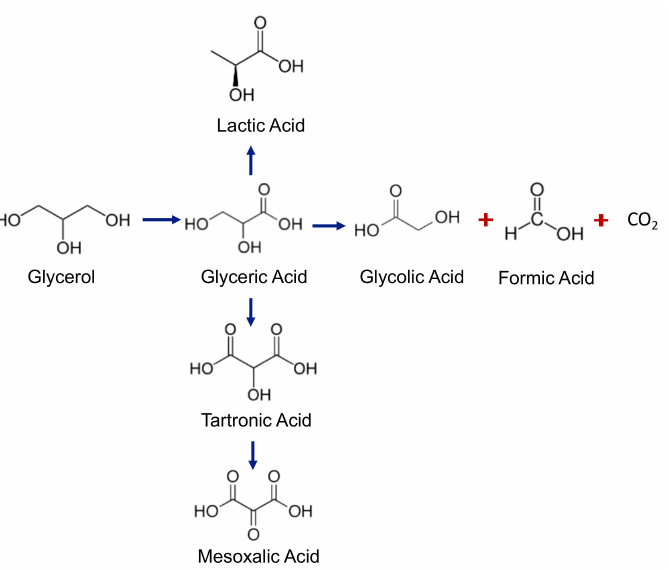
Figure 8. Scheme of the reaction mechanisms from the oxidation of glycerol in a basic medium. Figure produced by the present authors based on